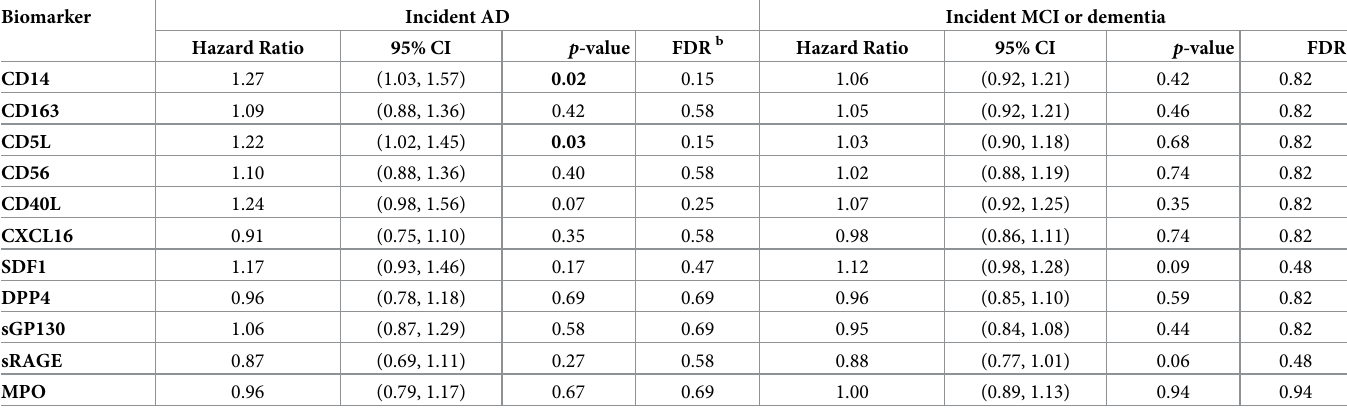
Table 3. Association of protein biomarkers with incident AD and MCI or dementia within 10-year follow-up a .